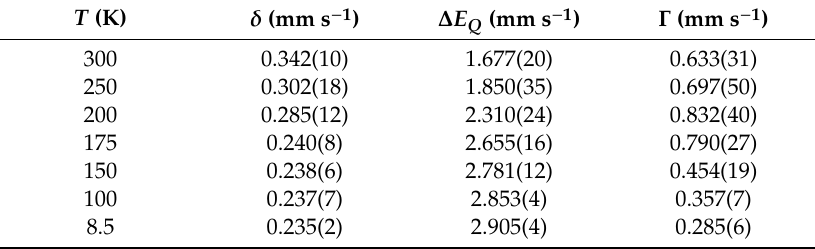
Figure 5. ( a ) Variable-temperature 57 Fe Mössßauer spectra of 1 between 8.5 and 300 K under zero applied dc magnetic field. Black crosses and solid red lines represent experimental data and fits, respectively. ( b ) Temperature dependence of δ (upper plot), Δ E Q (middle plot), and Γ (lower plot) of 1 . Solid black lines serve as guides. Table 6. Summary of 57 Fe Mössßauer spectral parameters for 1 .